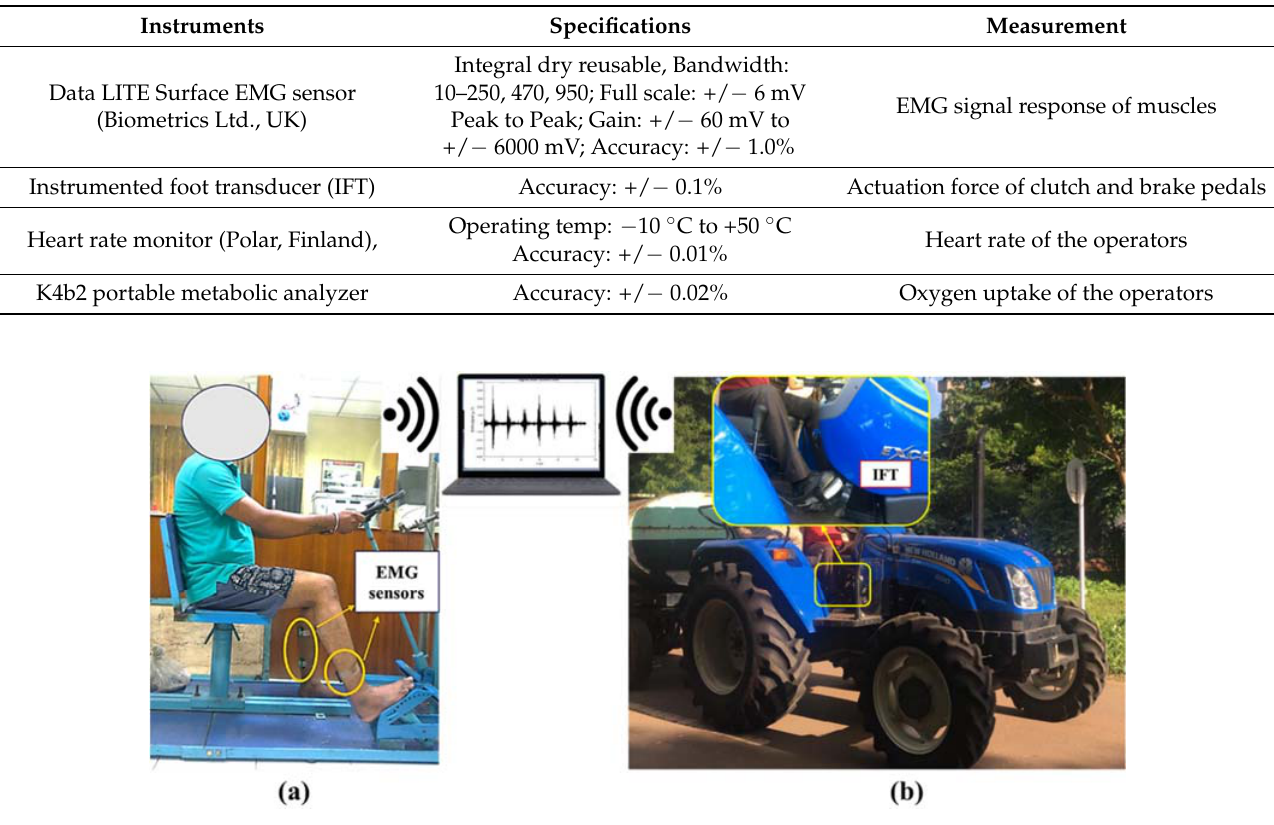
Table 2. Sensor and instrumentation specifications used in the study.